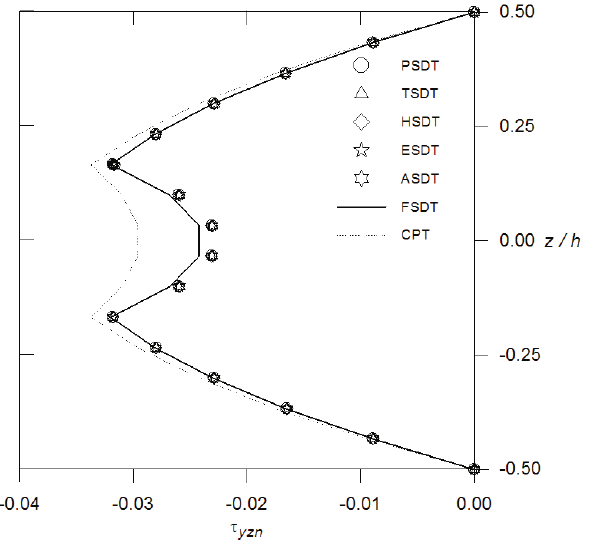
Figure 9: Variation of normalized transverse shear stress τ yz across the thickness for three layered (0 ∘ /90 ∘ /0 ∘ ) symmetric laminated composite square plate for aspect ratio